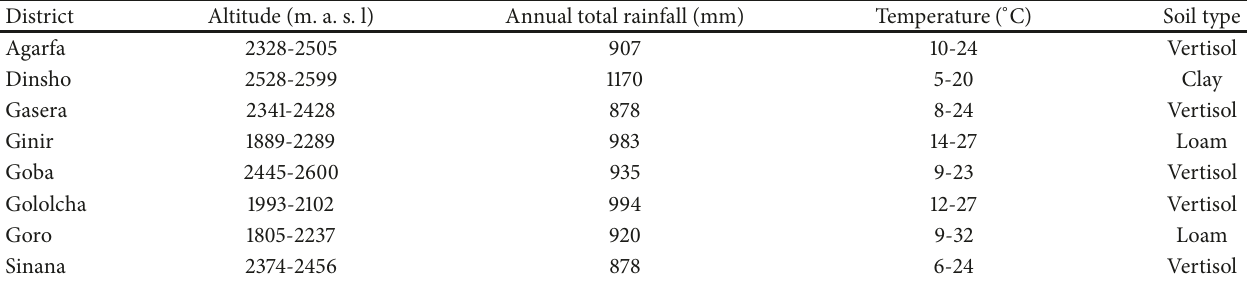
Table 1: Characteristic features of surveyed faba bean fields in eight districts of Bale highlands, south eastern Ethiopia. District Altitude (m. a. s. l) Annual total rainfall (mm) Agarfa 2328-2505 Dinsho